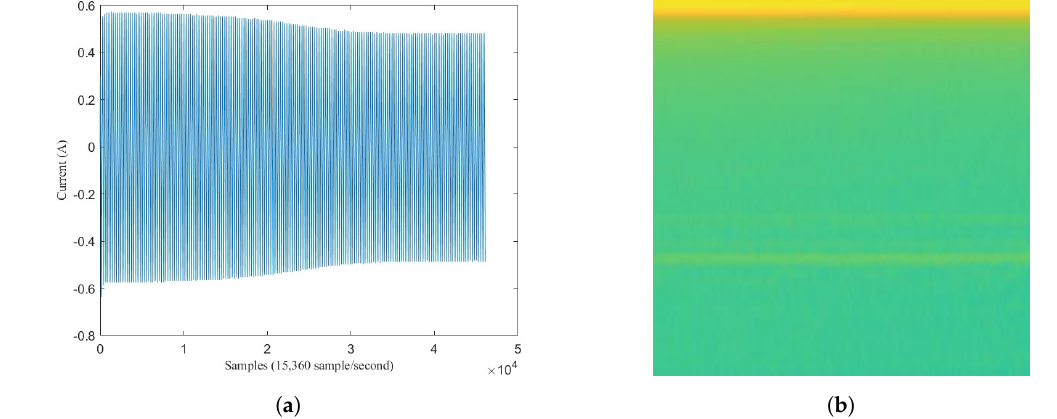
Figure 16. Fume Extractor: ( a ) load signal; ( b ) spectrogram image.